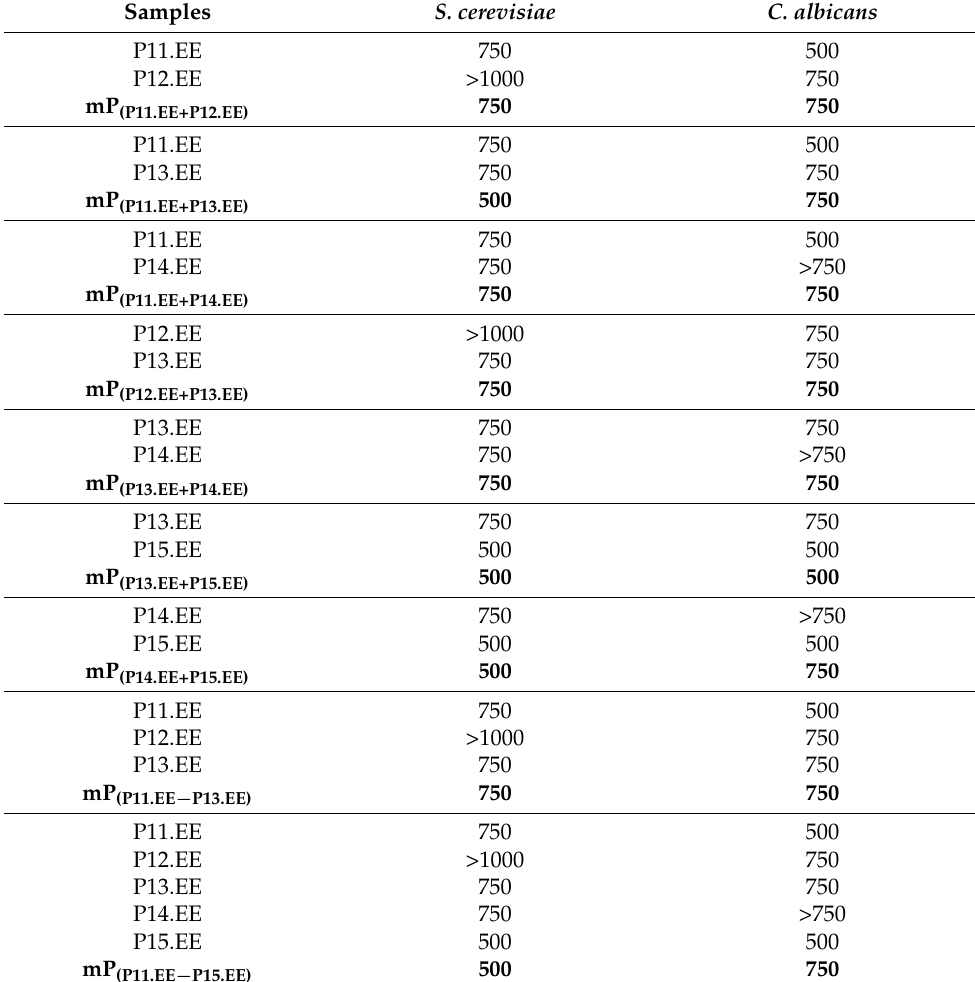
Table 4. MIC values ( µ g/mL) of the ethanol extracts of propolis from Pereiro collected from 2011 to 2015 and of the mixtures of P.EEs against Saccharomyces cerevisiae and Candida albicans . The results show the mean ± standard deviation of three assays with three replicates each. Samples S. cerevisiae C.